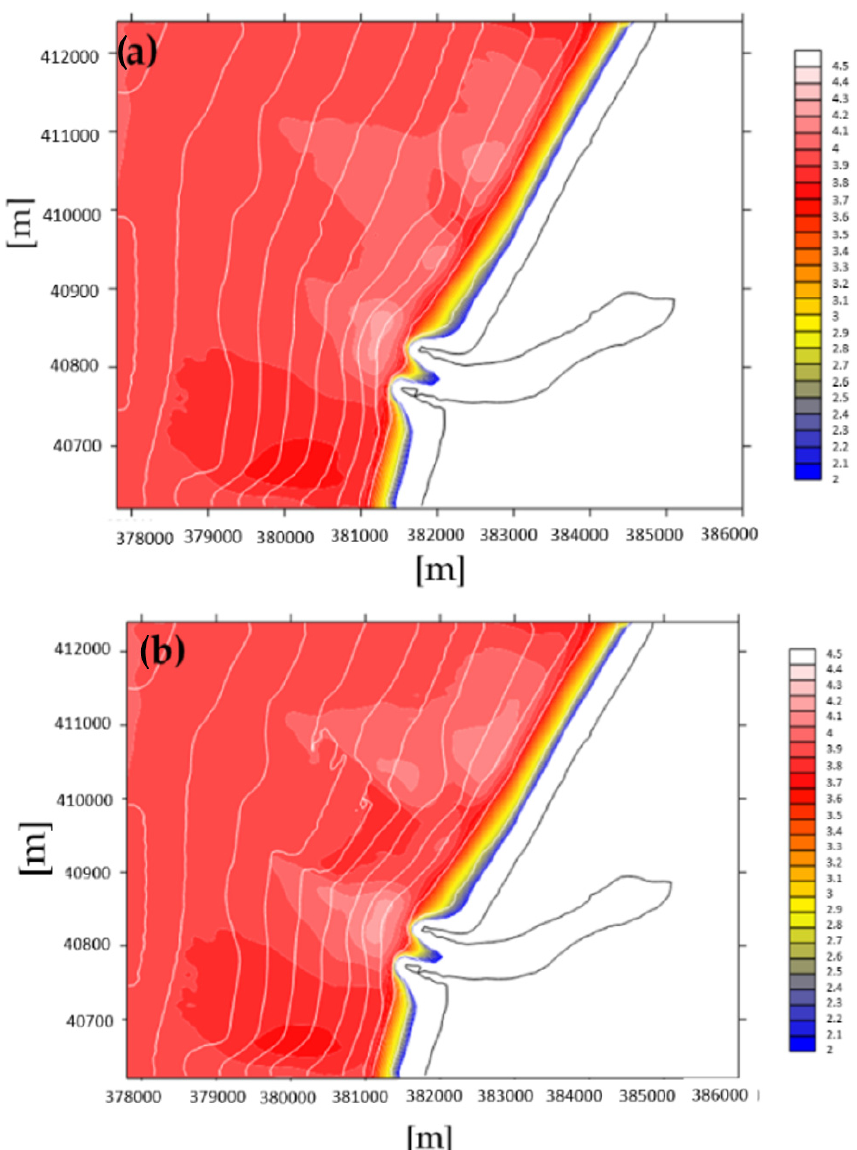
Figure 7. Map of local significant wave height distribution for ( H s 0 = 4 m, T p = 12 s), ( a ) before dredging, ( b ) after dredging of 2 m depth. The legend indicates the values of H s in meters.